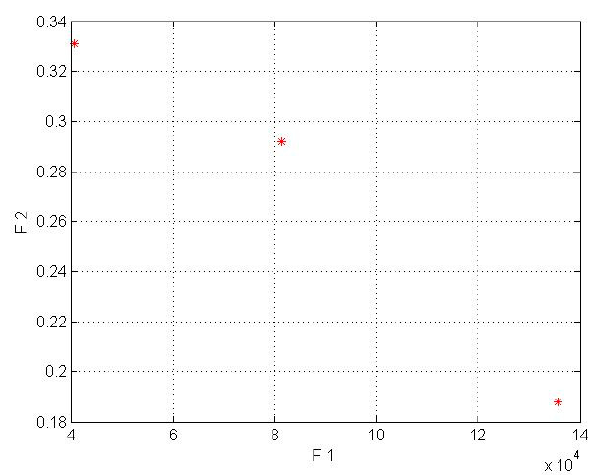
Figure 3. Pareto front results for a wind turbine without a lens in Firoozkooh (* shows COE by AEP).